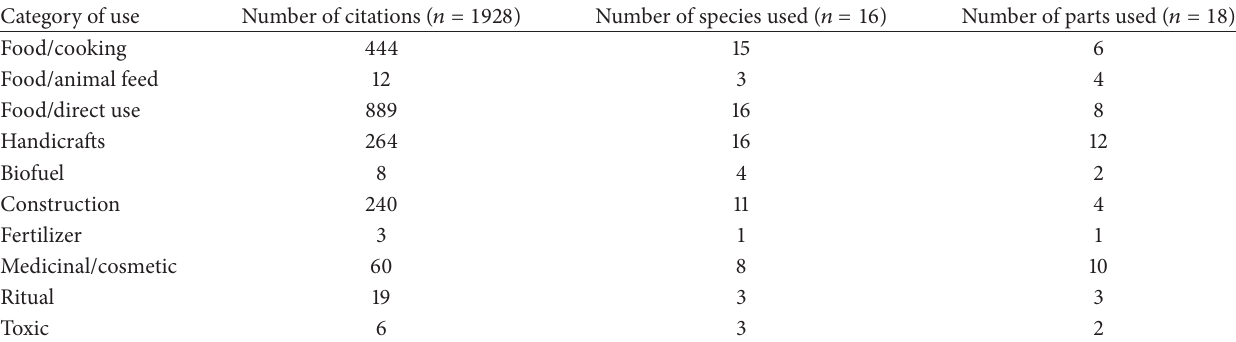
Table 4: Number of citations, species, and parts used for each category of palm use among the Kalunga from the Engenho II community, Cavalcante, GO, central western